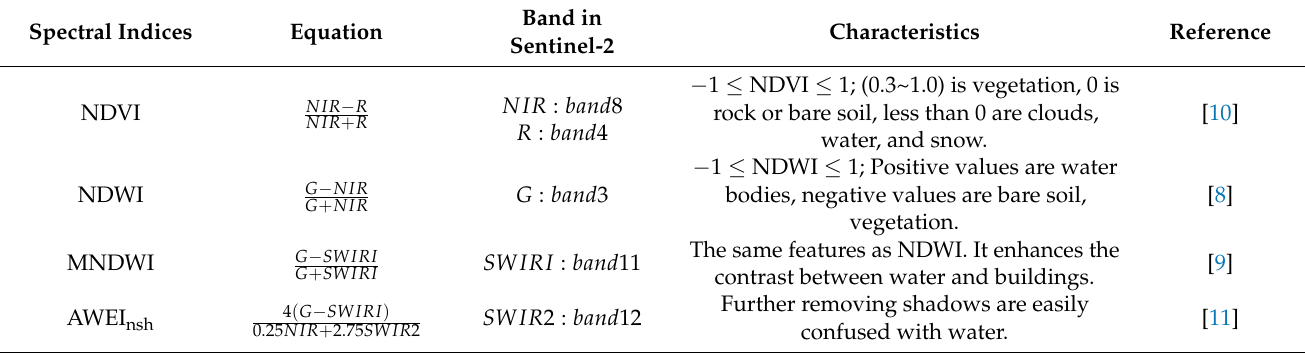
Table 3. Sentinel-2 optical images characteristics used for this